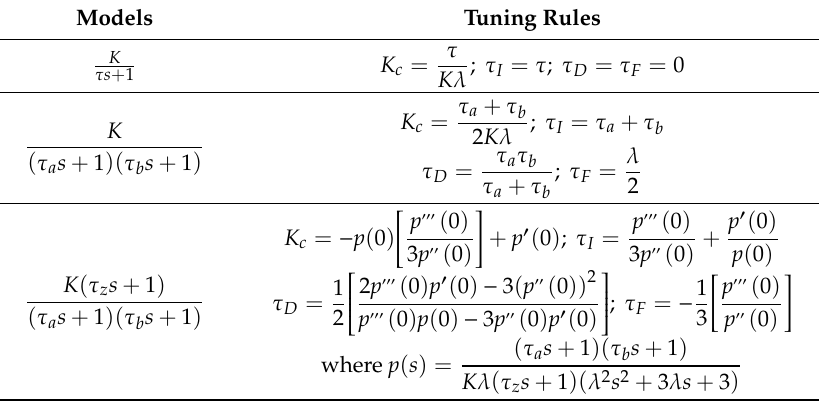
Table 3. Tuning rules for di ff erent types of delay-free process